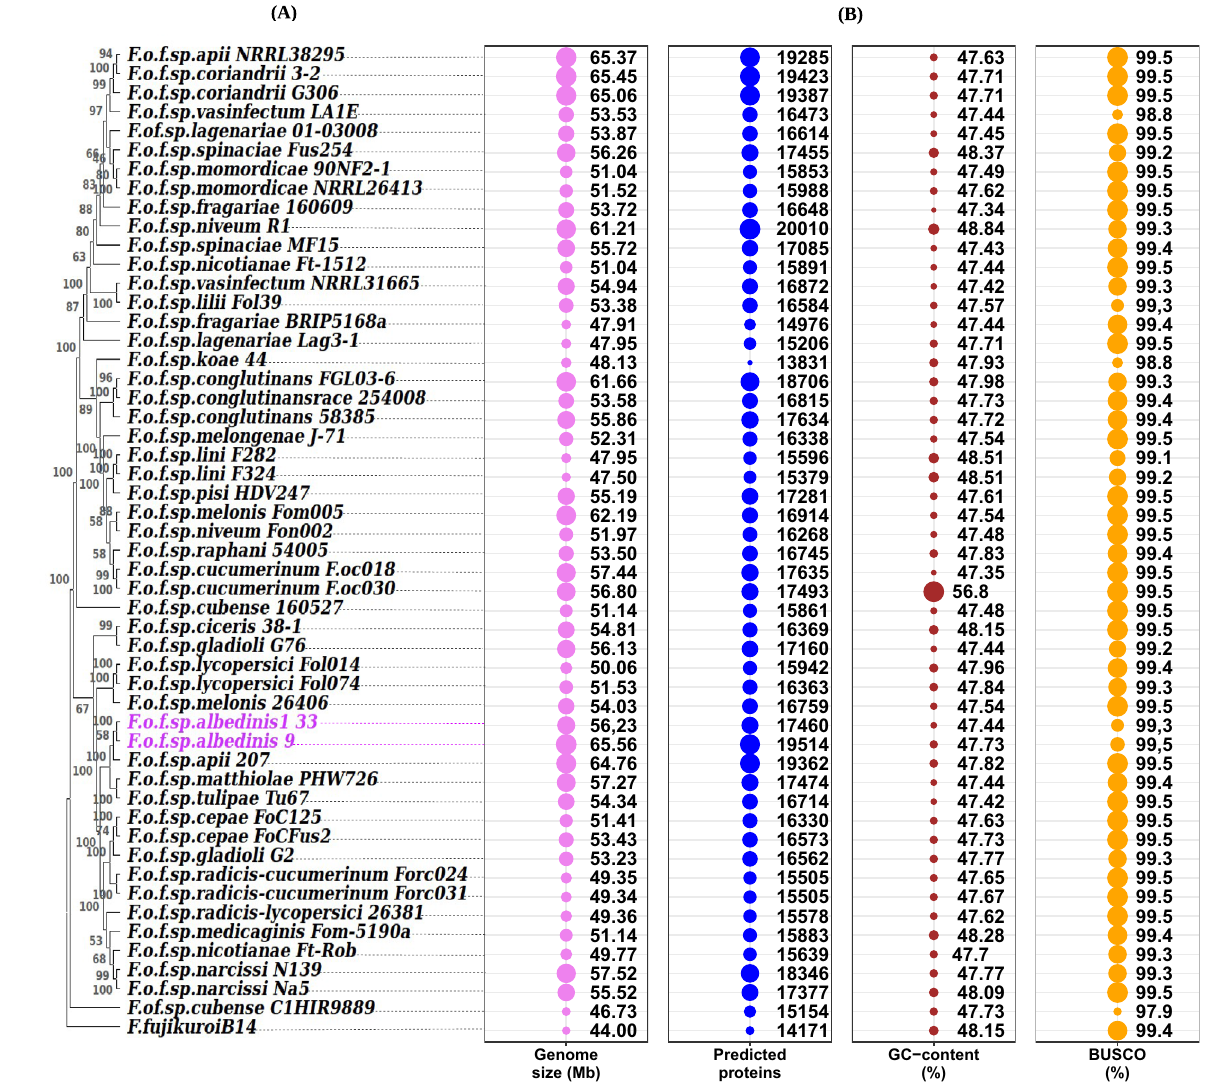
Figure 1. Bubble plots and Dendrogram illustrating the phylogenetic relationships between 49 genomes of the FOSC’s 29 formae speciales and two Foa genomes ( formae speciales of interest). ( A ), phylogenetic tree based on 263 orthologous genes in a single copy. ( B ), four bubble plots showing descriptive statistics for each genome. Bubble sizes have been scaled to the categories and are not comparable between categories. Abbreviations: F ( Fusarium ); o ( oxysporum ); f ( forma e); sp (speciales ). The names following the abbreviations represent the names of the formae speciales ; the abbreviations coming after the names of the formae speciales correspond to the strains belonging to these formae speciales (F.o.f.sp. albedinis 133: Fusarium osysporum forma specialis albedinis Foa